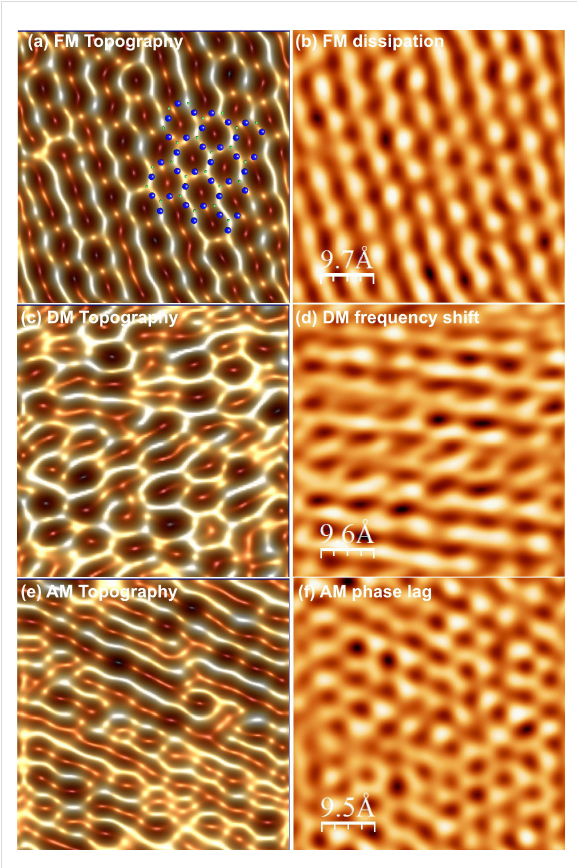
Figure 4: High-resolution images of mica in water taken with FM, DAM and AM. FM (a) topography and (b) dissipation. DAM (c) topography and (d) frequency-shift images. AM (e) topography and (f) phase-lag image. The variation in height in FM, DAM and AM topography images is 20, 80 and 40 pm, respectively, while the root-mean-squared surface roughness is 4, 13, and 6 pm, respectively. See Methods for additional